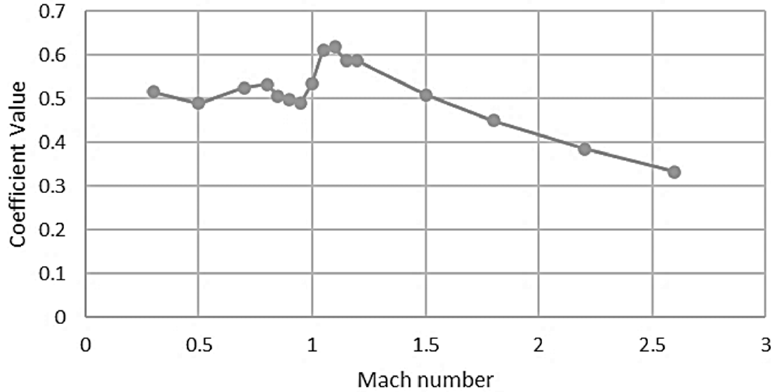
Figure 12. Mach number vs lift coefficient for an angle of attack of 2.4 degrees.